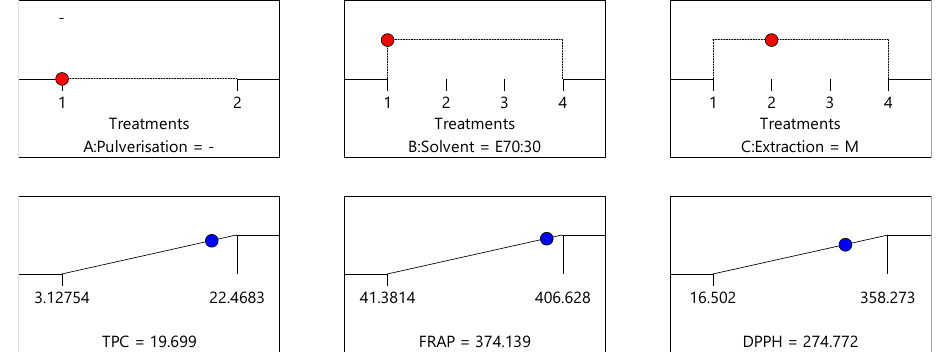
Figure 8. Proposed optimised extraction condition 2: crude/non-pulverised sample extracted using 70% ethanol:30% water (E70:30) and maceration (M), corresponding to the optimal conditions see in Figure 4 for TPC data, Figure 5 for DPPH data, and Figure 6 for FRAP data (desirability = 0.893).